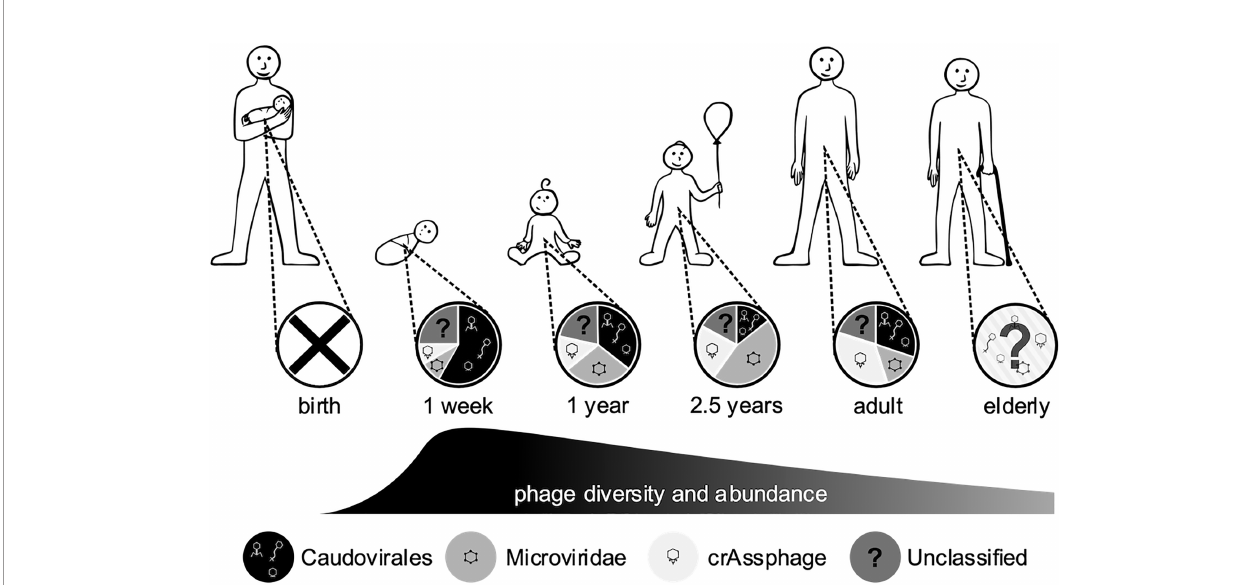
FIGURE 3 | Changes in the gut phageome over the human lifetime. Pie charts represent the observed ratios of different phage groups at discrete sampling times, from birth where no endemic phages were observed to adults, while the humped line describes changes in phage diversity and abundance over time, which both peak in the weeks after birth (Breitbart et al., 2008; Reyes et al., 2010; Kim et al., 2011; Lim et al., 2015; McCann et al.,